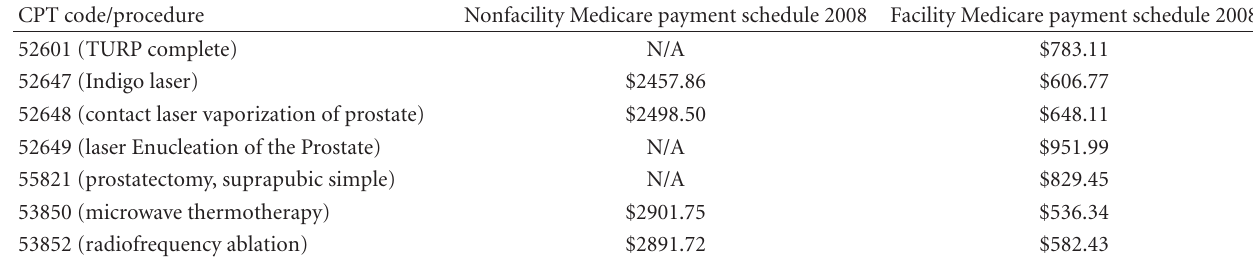
Table 1: 2008 Medicare physician payment data for BPH procedural therapies (figures are derived using the CMS listing for the 2008 fee schedule, the 2008 conversion factor, and the RBRVS